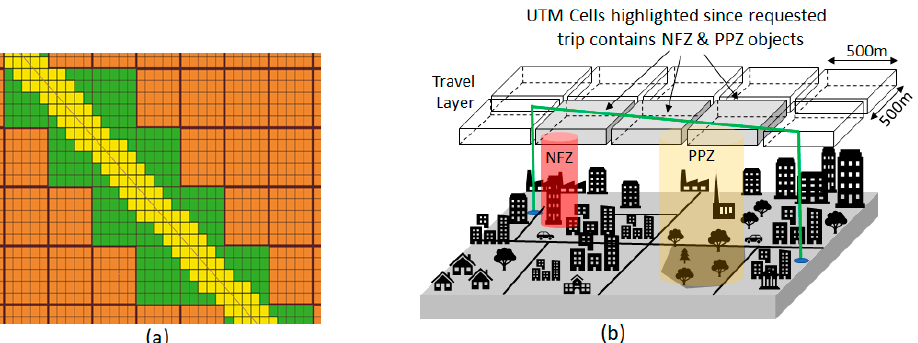
Figure 17. ( a ) Yellow area represents all 10 m by 10 m cells within 10 m of line and green area represents all 50 m by 50 m cells within 10 m of line; ( b ) Schematic of 500 m × 500 m UTM cells used as a spatial index for rapid database searching.